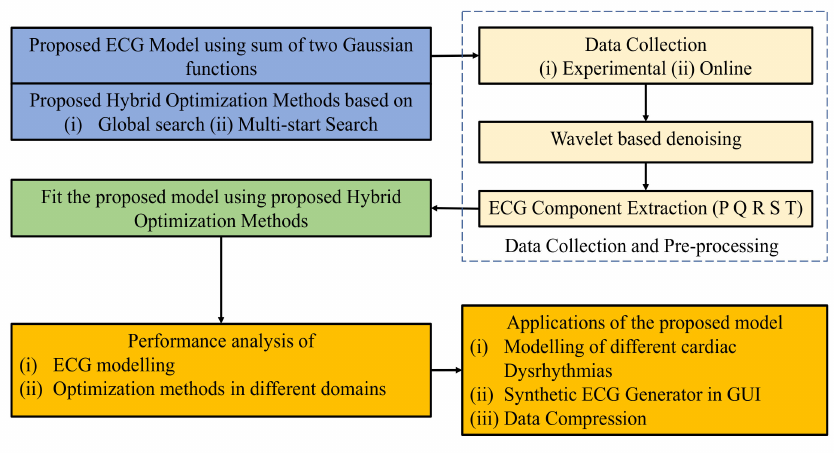
Figure 1. Proposed flow diagram of the